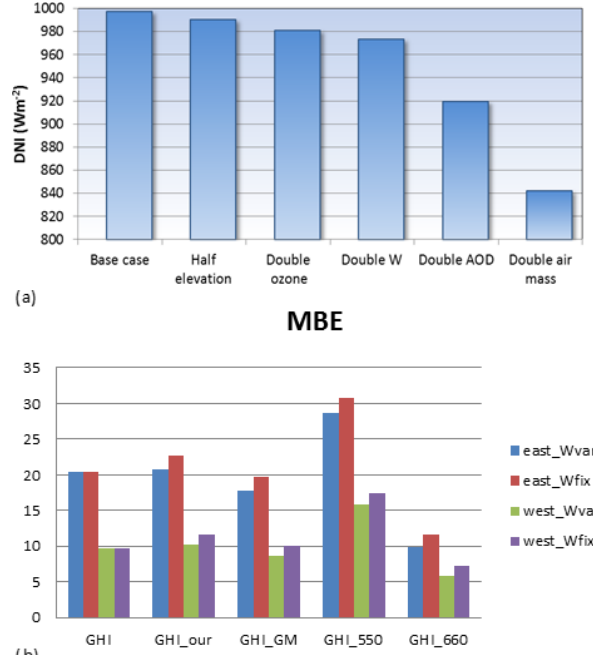
Figure 7. (a) Aerosol impact on DNI from Perez model estimations; ( b) NGACv2 AOD impact on Perez model solar energy estimation mean bias error (MSE). East – GOES eastern USA satellite; west – GOES western USA; Wvar – variable water vapor (GFS model); Wfix – monthly averaged water vapor (NASA); our – monthly av- eraged AOD used in ASRC (NASA); GM – Gueymard AOD; 550 and 660 – NGACv2